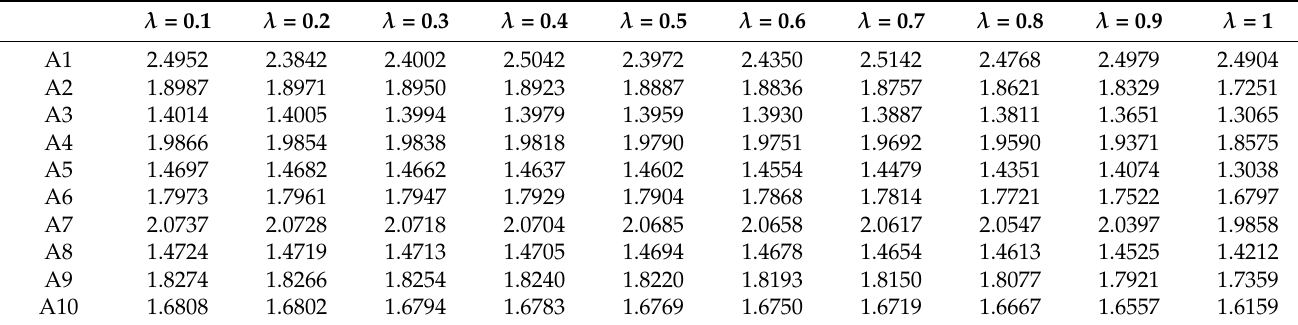
Table 5. Rankings of robots for varying λ